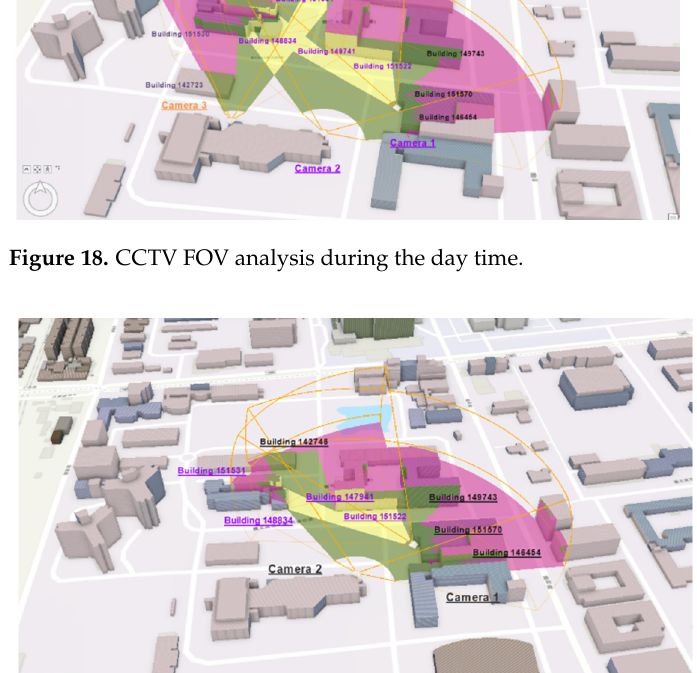
Figure 19. CCTV FOV analysis during the night time.